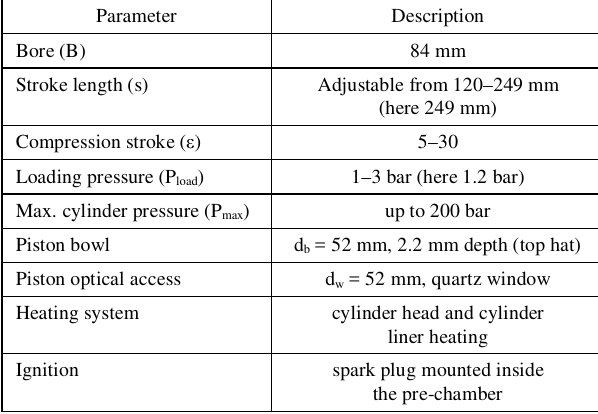
Table 1. Technical characteristics of the Rapid Compression Expansion Machine